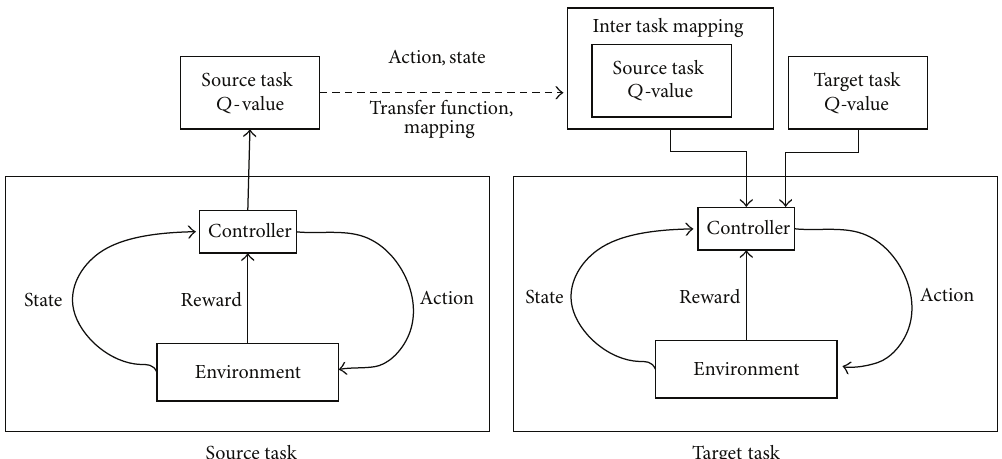
Figure 2: Framework of reinforcement learning with transfer learning. The 𝑄 -value from the source tasks is also involved in the target tasks through transfer function.